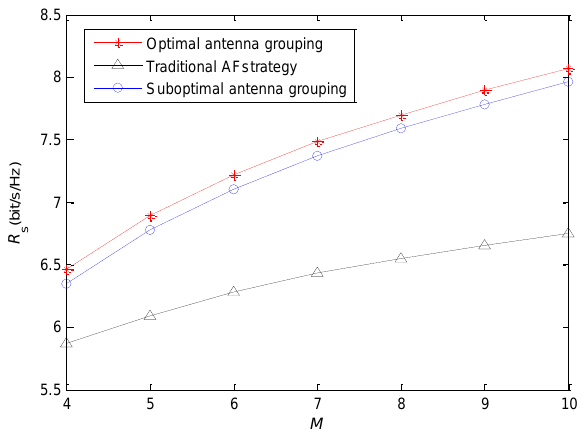
Figure 5. Relationship between antenna number of relay and secrecy rate.